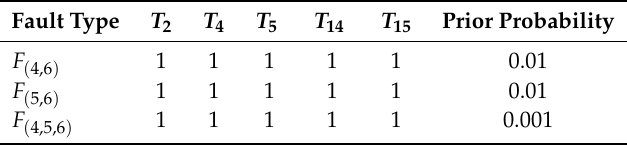
Table 9. Table 9. Fault fuzzy groups of the system in Experiment